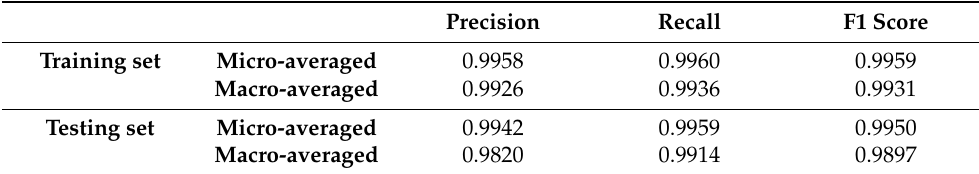
Table 3. Evaluation result of training and testing